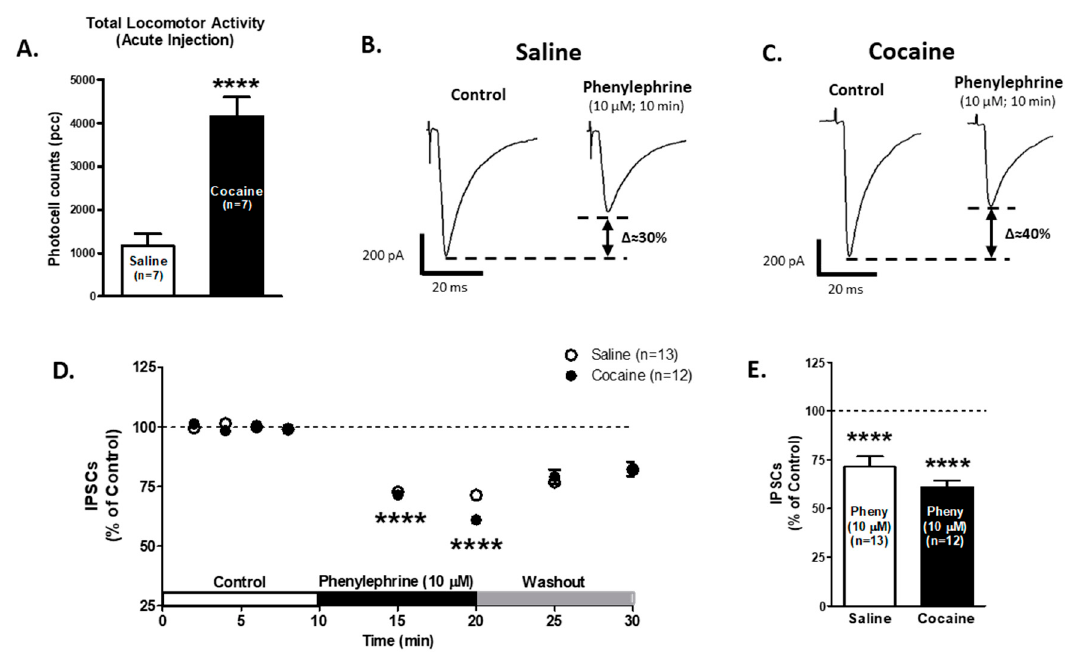
Figure 5. α 1-ARs-mediated effect on GABA A IPSCs amplitude is not affected in VTA DA neurons